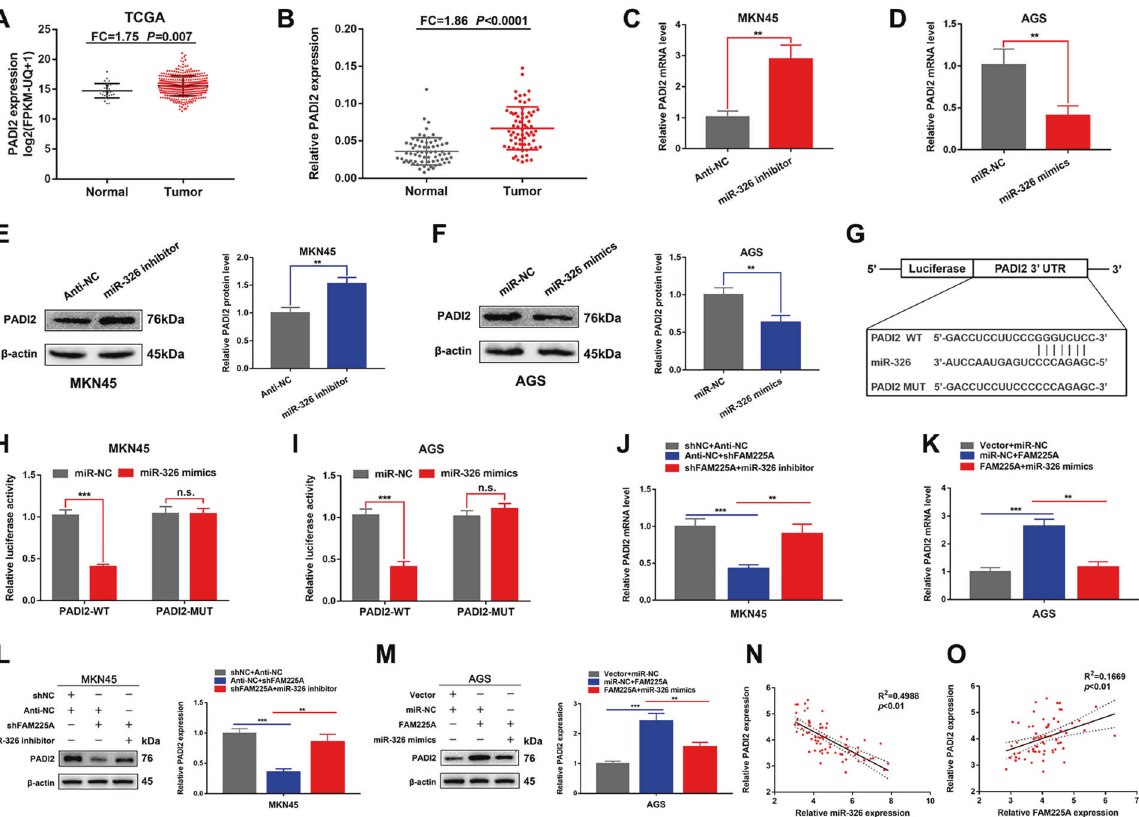
Fig. 6 FAM225A modulates PADI2 expression by competitively binding miR-326. A , B Relative expression of PADI2 in GC tissues according to TCGA database and our own 68 GC tissues. C – F Detecting PADI2 mRNA and protein expression when knockdown or overexpression of miR- 326 in MKN45 or AGS cells by using qRT-PCR and western blot. G Predicting binding sites between PADI2 and miR-326. H , I The relative luciferase activity of the wild-type PADI2 was reduced by upregulating miR-326. J – M Detecting PADI2 mRNA and protein expression when MKN45 cells transfected with siNC + Anti-NC, Anti-NC + siFAM225A, siFAM225A + miR-326 inhibitor, or when AGS cells transfected with Vector + miR-NC, miR-NC + FAM225A, FAM225A + miR-326 mimics by using qRT-PCR and western blot. N , O The correlation between